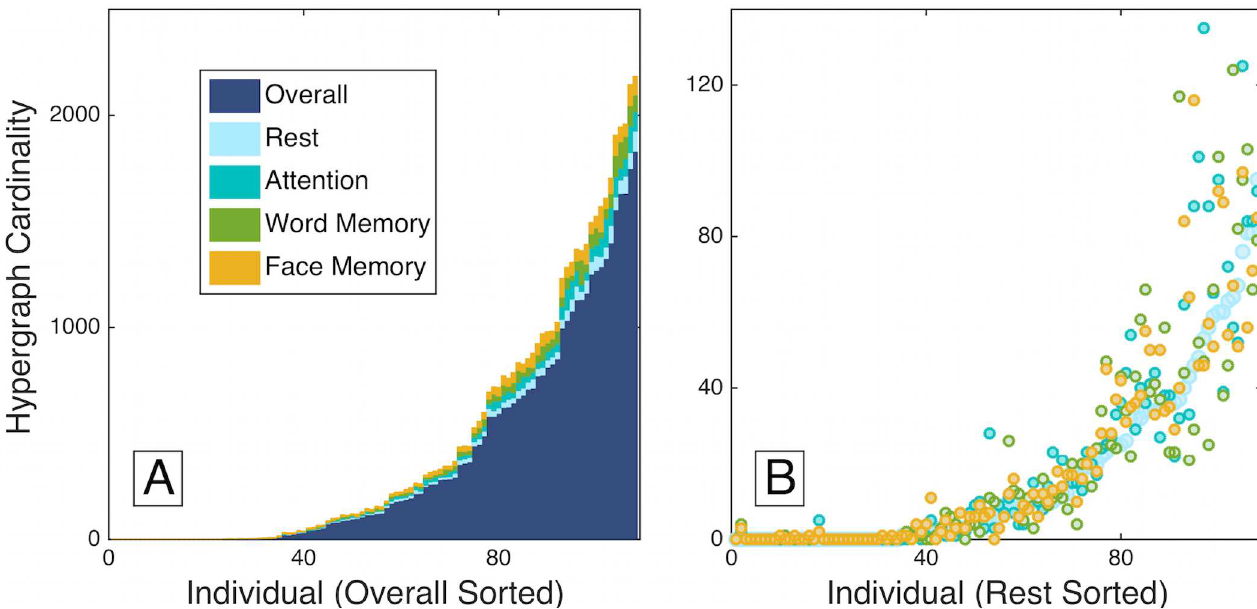
Fig 5. Individual variability. Hypergraph cardinalityfor individualoverall multi-task hypergraphs is shown in panel (A), sorted by increasingoverall cardinality. Individualtask-specific hypergraph cardinalityis shown atop the overall cardinalityfor comparison, and is also sorted by increasing overallcardinality. Panel (B) depicts the cardinalityfor task-specific hyperedges, sorted by rest cardinality. The number of hyperedgesacross tasks is fairly consistent within individuals, in contrast to the range of hyperedge number across individuals.